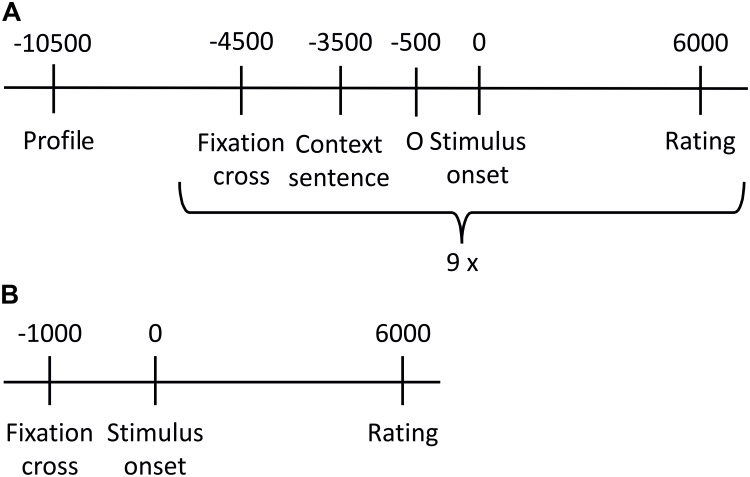
Overview of stimulus presentation procedure. (A) One of the 20 presentation blocks created for the prosodic stimuli. All nine stimuli of one block were spoken by the same speaker, and included in randomized order three neutral, three anger and three joy sentences. (B) Stimulus presentation of sounds.